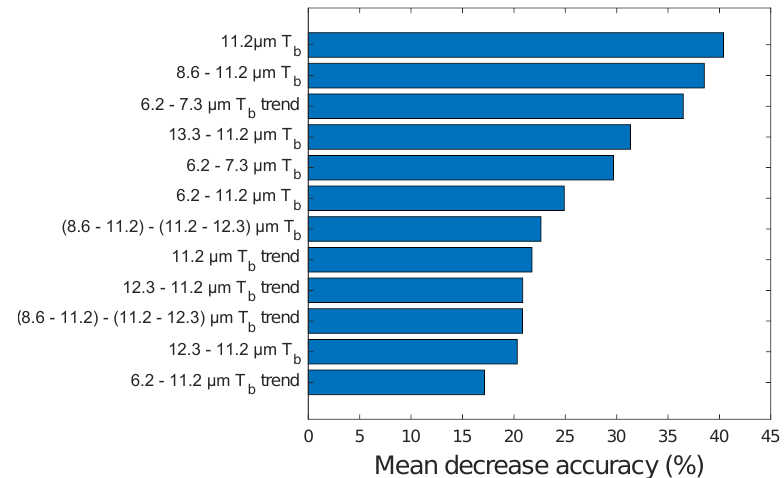
Figure 4. The mean decrease accuracy of 12 interest fields in the RF model using all samples (Groups A, B, C, and D). A higher mean decrease accuracy is interpreted as indicating a more significant variable in the random forest (RF) model.